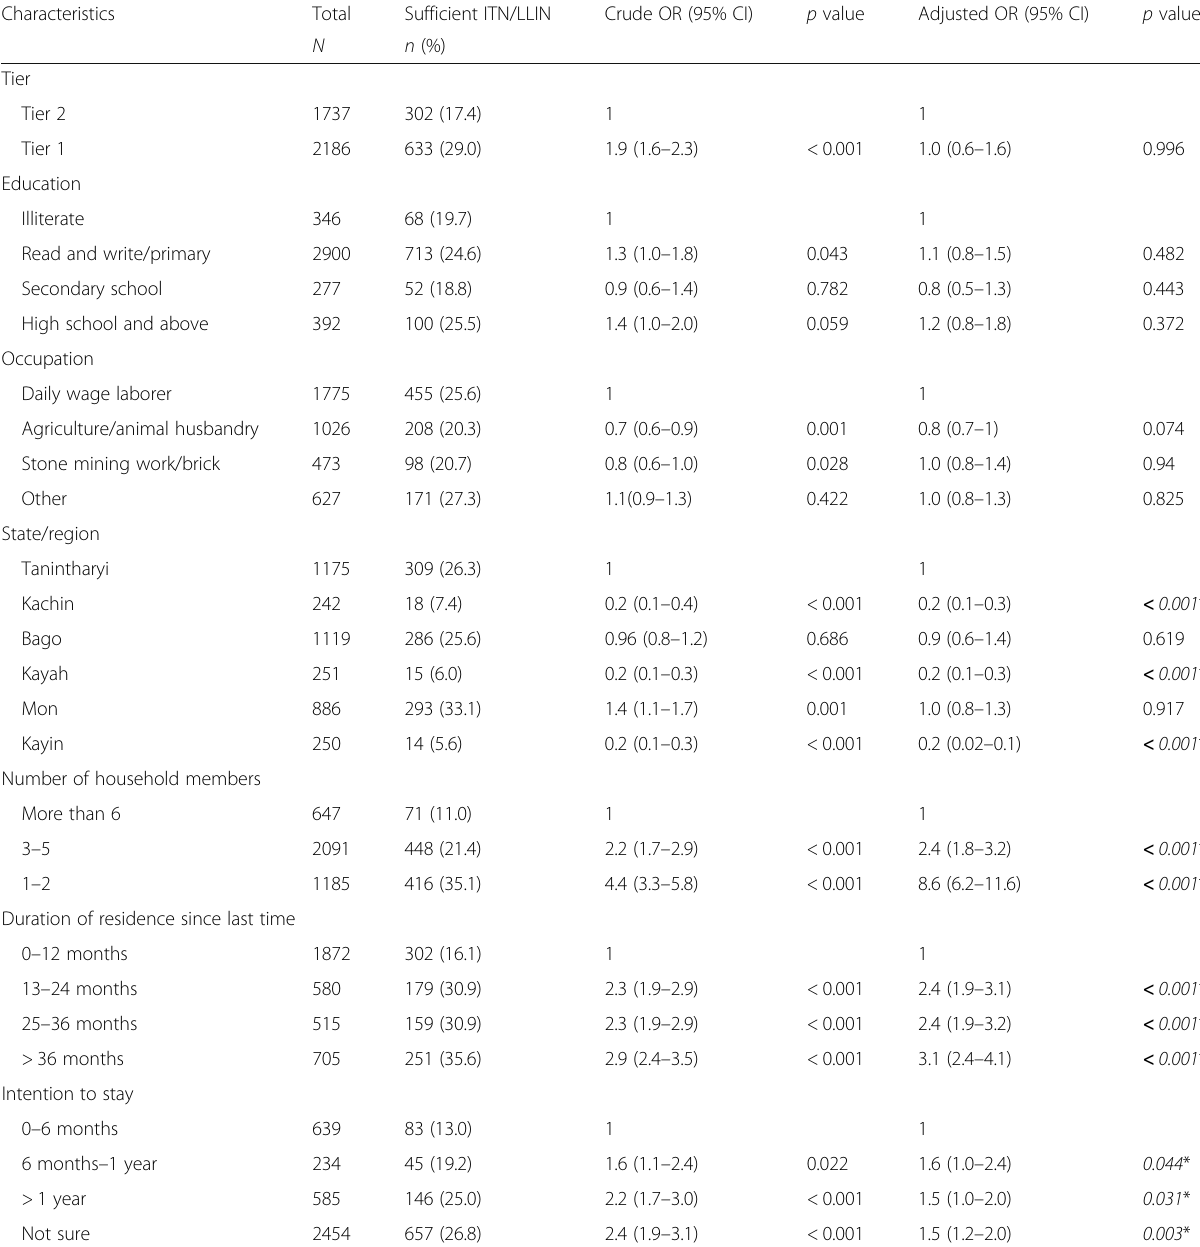
Table 5 Factors associated with ownership of sufficient ITN/LLINs among the migrant population in RAI project areas of